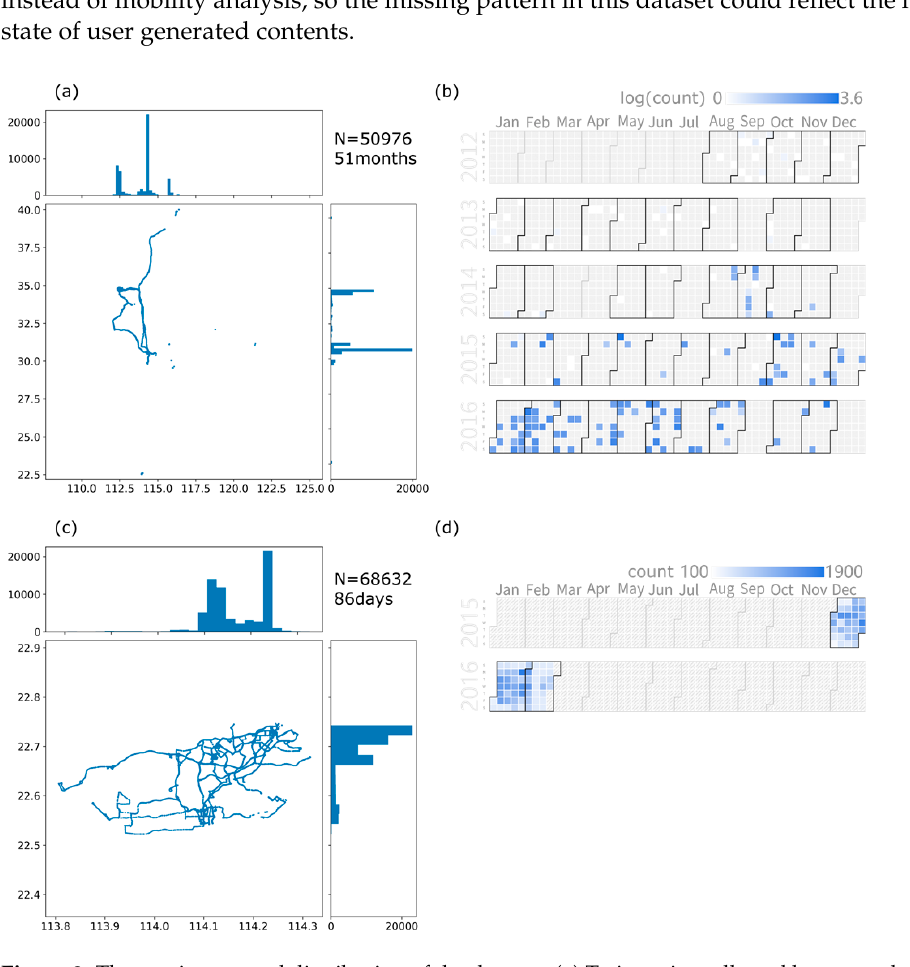
Figure 3. The spatiotemporal distribution of the datasets ( a ) Trajectories collected by smartphone and social media check-ins of a student in Central China. Top and right panels are one-dimensional histograms of point coordinates. ( b ) Temporal distributions of student dataset, shading is proportional to the logarithm of number of data points collected in a day. ( c ) Trajectories collected by private car of an employee in Shenzhen, China. ( d ) Temporal distributions of clerk dataset, shading is proportional to the number of data points collected in a day.